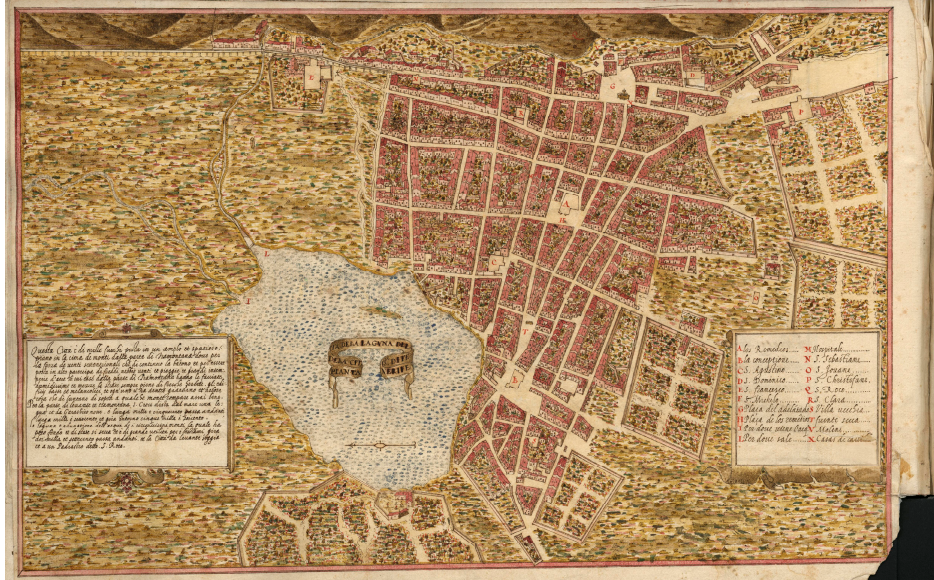
Figure 2. The map of San Cristóbal de La Laguna by Leonardo Torriani in 1588.